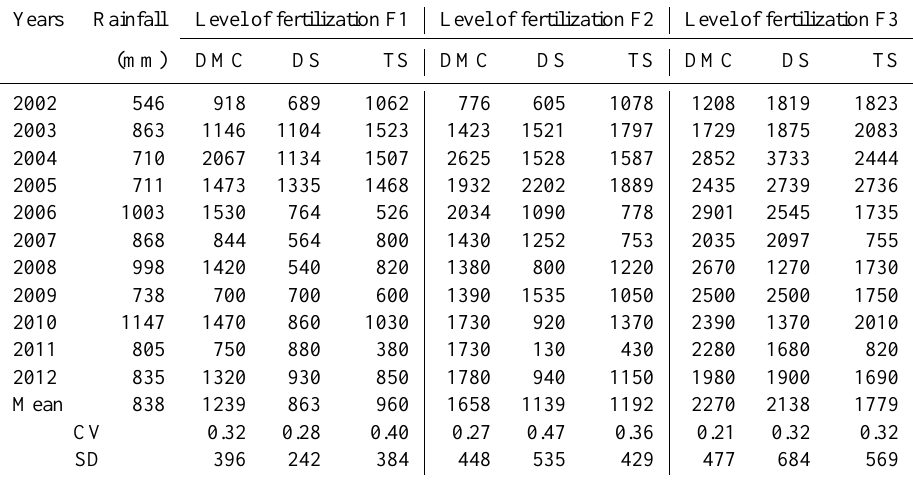
Table 2. Yields in kgha − 1 at different level of fertilization (F1, F2, F3) and mean annual rainfall over the studied site from 2002 to 2012 (Source: